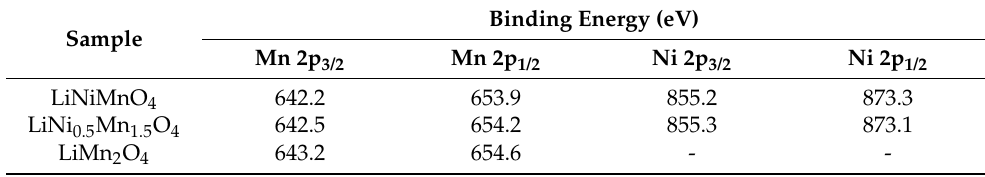
Table 3. Binding energies of Mn and Ni core levels for the spinel